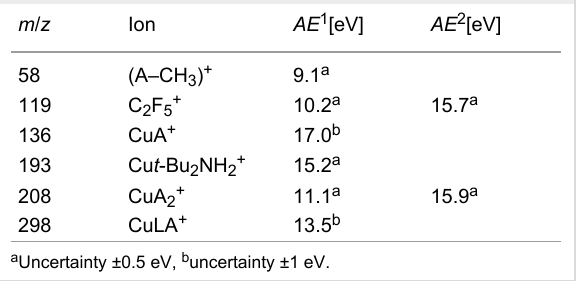
Table 3: Appearance energies for selected ions from dissociation of [Cu 2 ( t -BuNH 2 ) 2 (µ-O 2 CC 2 F 5 ) 4 ] induced by electron impact ionization.